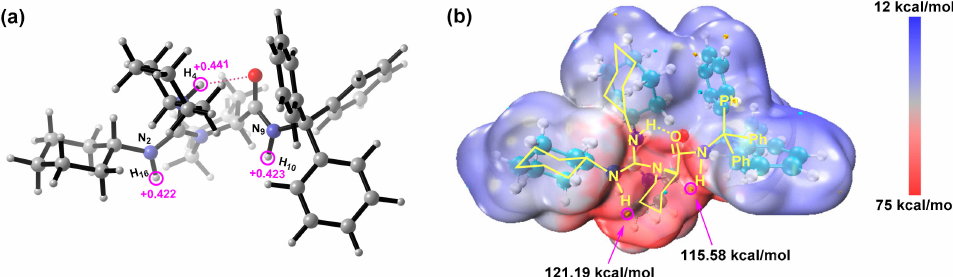
Figure 2. ( a ) The natural atom charges at H atoms in guanidine cation species, obtained by natural bond orbital (NBO) analysis. ( b ) Electrostatic potential (ESP) mapped Van der Waals surface of protonated G1. The redder the color, the more positive the ESP. The purple and red spheres represented the local minima and maxima points, respectively.